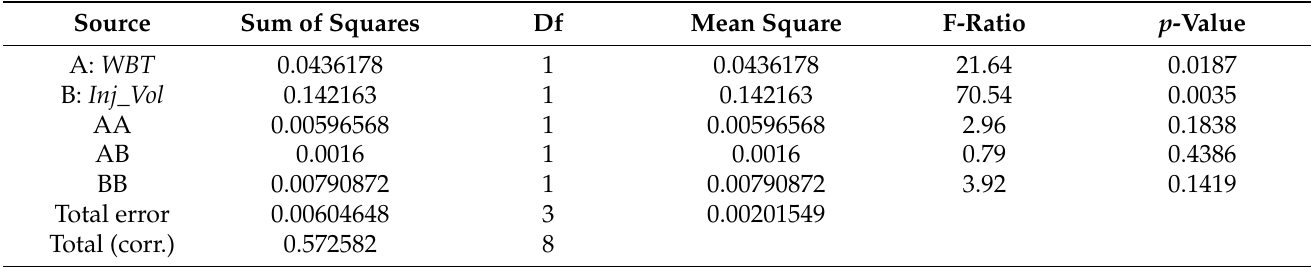
Table 4. Analysis of Variance for the restart pressure of the gradual injection model.